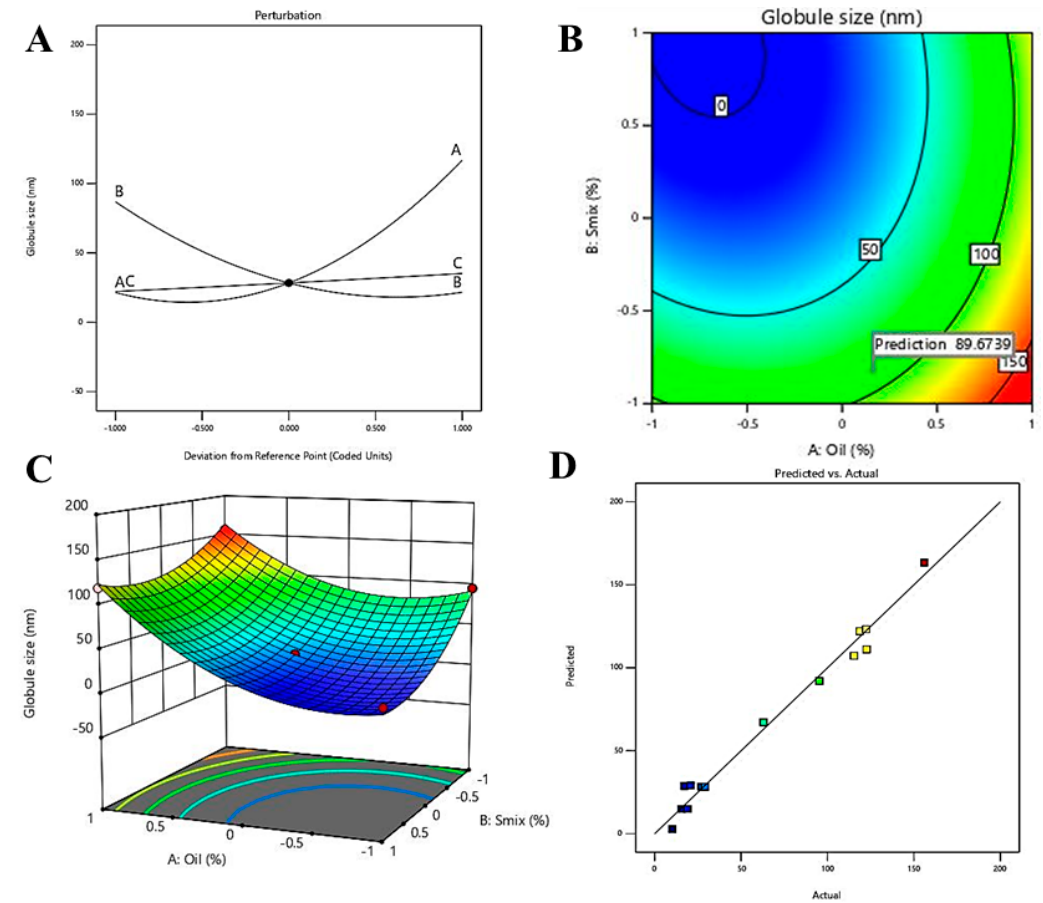
Figure 4. Effect of independent variables on droplet size: ( A ) perturbation graph, ( B ) contour plot, ( C ) 3D surface plot and ( D ) predicted vs. actual graph.